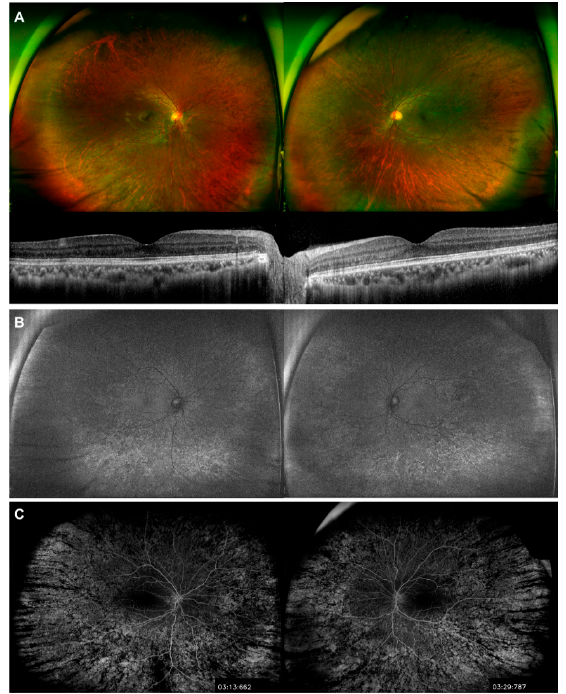
Figure 4. Images of peripheral retinopathy associated with Danon disease obtained after twelve years of follow-up (patient at 33 years old). ( A ) Ultra-widefield fundus images show an indolent peripheral pigmentary retinopathy that does not extend to the macular area (top). OCT images of both eyes show a well-preserved macular area (bottom); ( B ) ultra-widefield fundus autofluorescence; ( C ) fluorescein angiography images show di ff use retinal pigment epithelial atrophy confined to the peripheral retina without further extension to the macular area compared to the images of the initial